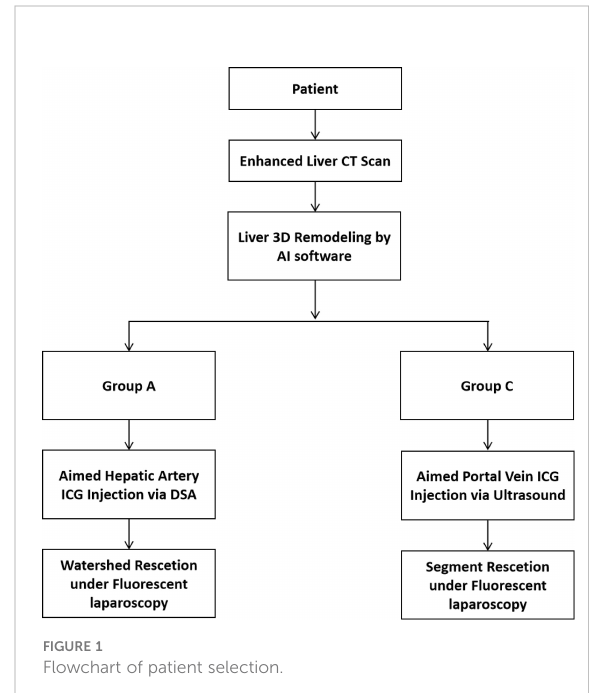
FIGURE 1 Flowchart of patient selection.